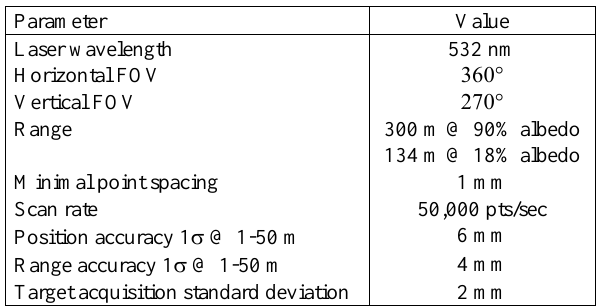
Table 1. Leica ScanStation C10 selected